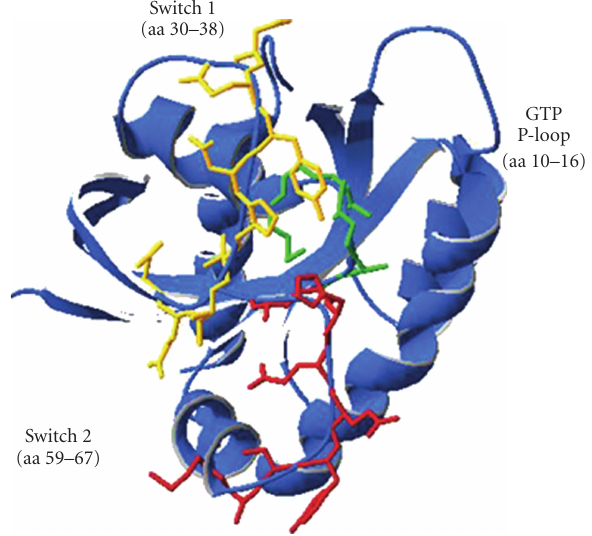
Figure 3: Model of the KRAS protein with important domains highlighted. Model of 3GFT molecule was rendered in Swiss- PdbViewer v4.0.1 (http://spdbv.vital-it.ch/). Switch 1, Switch 2, and GTP P-loop domains are highlighted by colour